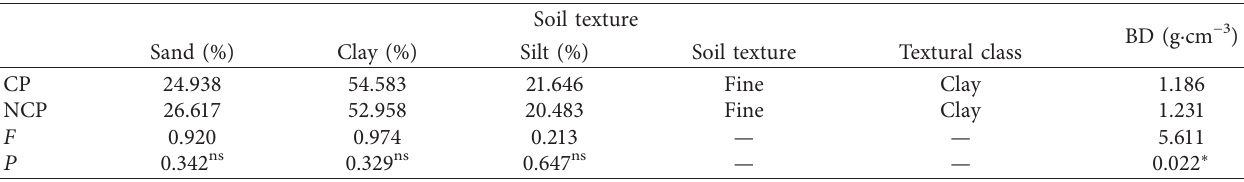
Table 1: Comparisons of the mean values of sand, silt, clay contents, and bulk density under different SWC treatments and the non- conserved